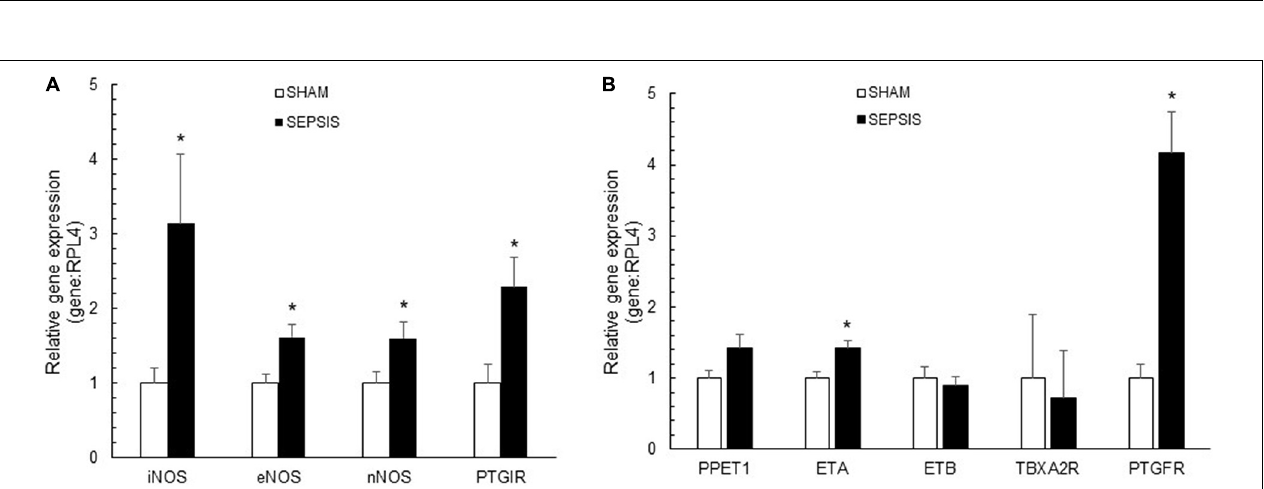
FIGURE 4 | Coronary artery expressions of vasoactive molecules. Relative gene expressions of inducible (iNOS or NOS2), endothelial (eNOS or NOS3), and neuronal (nNOS or NOS1) nitric oxide synthase and prostaglandin I receptor (PTGIR), implicated in vasodilatory pathways (A) and relative gene expression of prostaglandin F 2 α receptor (PTGFR), endothelin receptor type A (ETA) and B (ATB), thromboxane A2 receptor (TBXA2R), implicated in vasoconstrictor pathways (B) , in coronary arteries from sham (white bars; n = 7) and sepsis (black bars; n = 7) groups. Results are expressed as mean ± SEM. * p < 0.05 sepsis vs. sham groups.